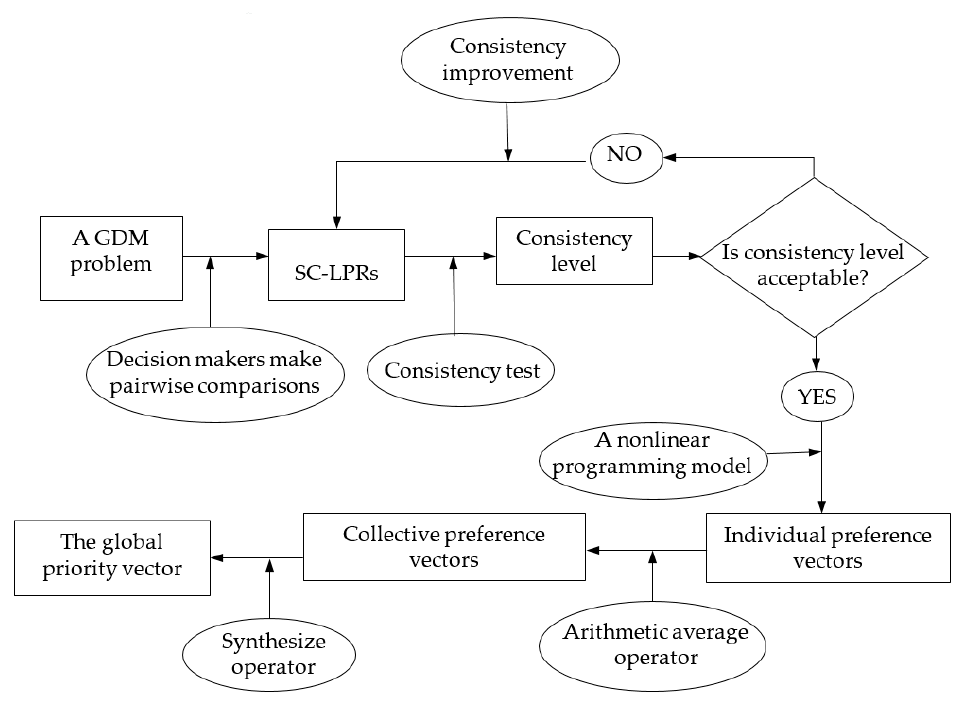
Figure 2. Flowchart of LHM-SCPR.